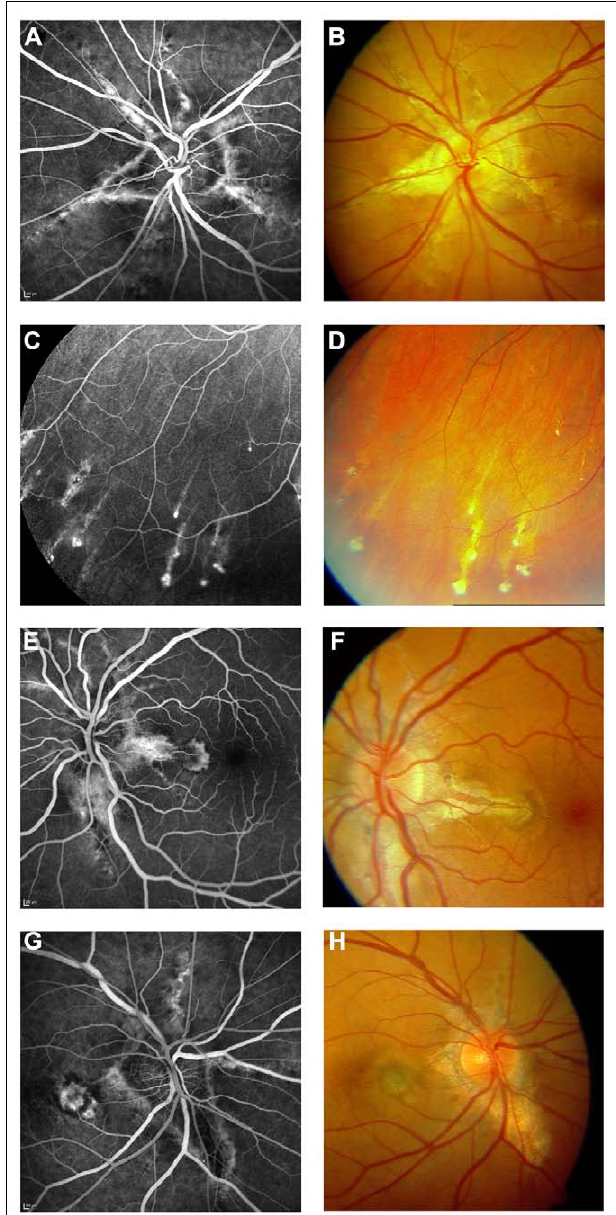
FIGURE 3 | Features of pseudoxanthoma elasticum on fluorescein angiography. Angioid streaks typically show a variable staining on fluorescein angiography (A,B) . Comet tail lesions appear as hyperfluorescent spots with their tail toward the optic disk (C,D) . Choroidal neovascularizations are mostly classic membranes. Sometimes, their detection may be difficult due to adjacent staining of angioid streaks (E–H) .